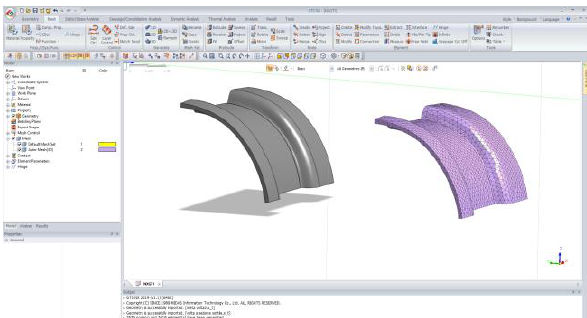
Figure 10 . View of the vault of the bridge in GTS NX